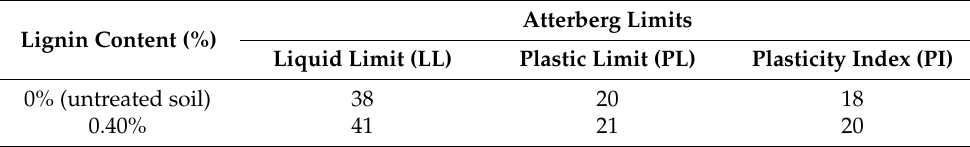
Table 5. Atterberg limits recorded for the untreated soil and the 0.40% lignin-treated soil. Atterberg Limits Lignin Content (%) Liquid Limit (LL) Plastic Limit (PL) Plasticity Index (PI) 0% (untreated soil) 38 20 0.40%